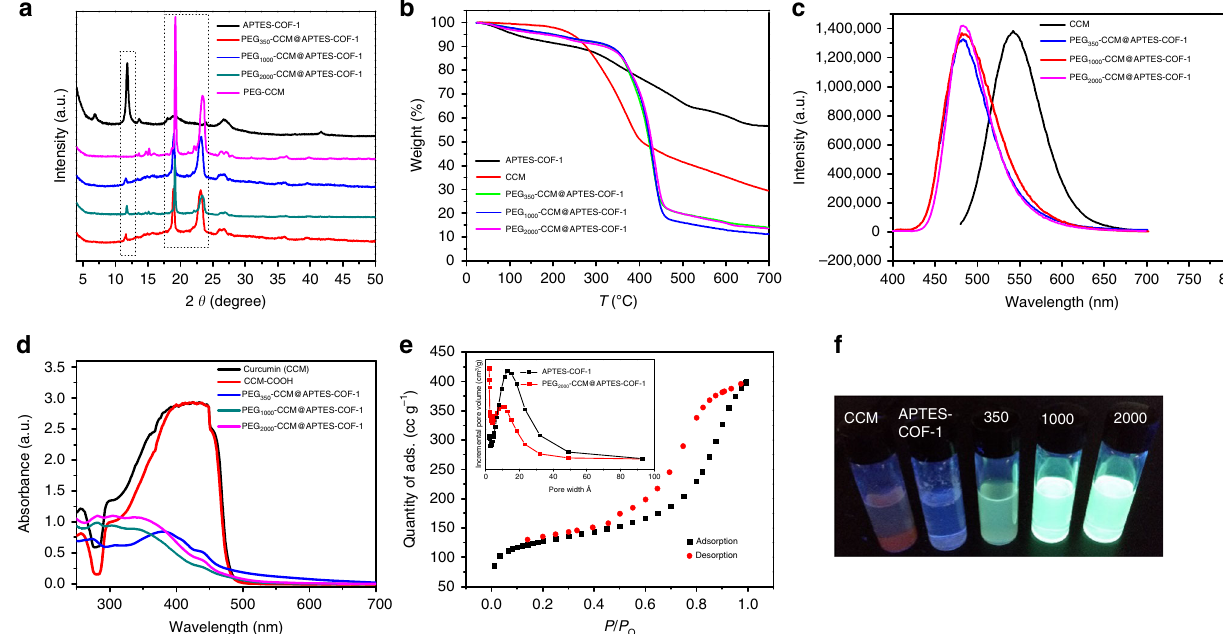
Fig. 3 Structural characterizations and fl uorescence photograph. a PXRD patterns of APTES-COF-1 (black solid line), PEG 350 -CCM@APTES-COF-1, PEG 1000 -CCM@APTES-COF-1, and PEG 2000 -CCM@APTES-COF-1. b TGA curves of the as-synthesized CCM, APTES-COF-1, PEG 350 -CCM@APTES-COF-1, PEG 1000 -CCM@APTES-COF-1, and PEG 2000 -CCM@APTES-COF-1 under air atmosphere. c PL spectra of free CCM (black solid line), PEG 350 - CCM@APTES-COF-1, PEG 1000 -CCM@APTES-COF-1, and PEG 2000 -CCM@APTES-COF-1. d UV − vis spectra of the COF-based materials in methanol solution. e N 2 adsorption (black) and desorption (red) analysis of APTES-COF-1. The inset shows the DFT pore size distribution. f Photographs of free CCM, APTES-COF-1, PEG 350 -CCM@APTES-COF-1, PEG 1000 -CCM@APTES-COF-1, and PEG 2000 -CCM@APTES-COF-1 at the same concentration under blue-light excitation (365